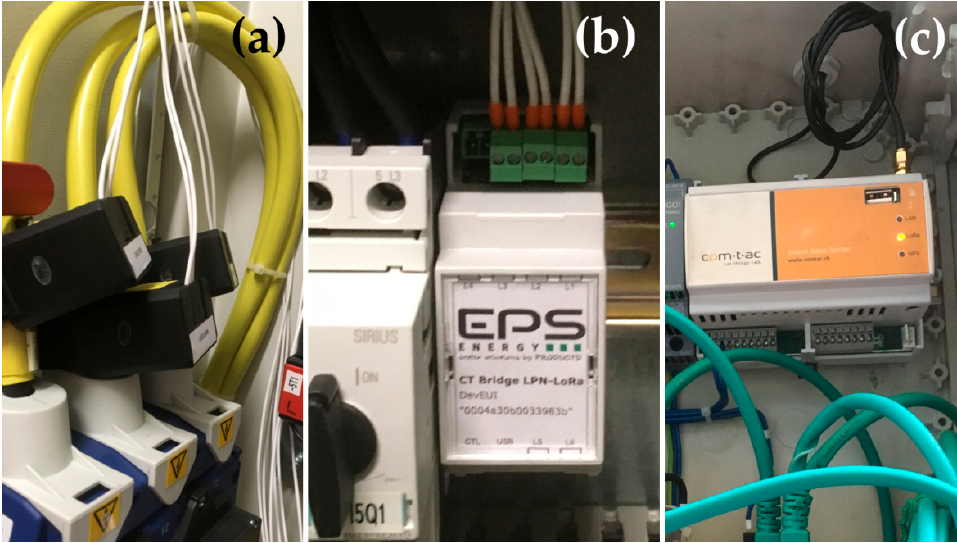
Figure 4 . The setup with the CT ( a ), the CT bridge ( b ), and the base server ( c ).